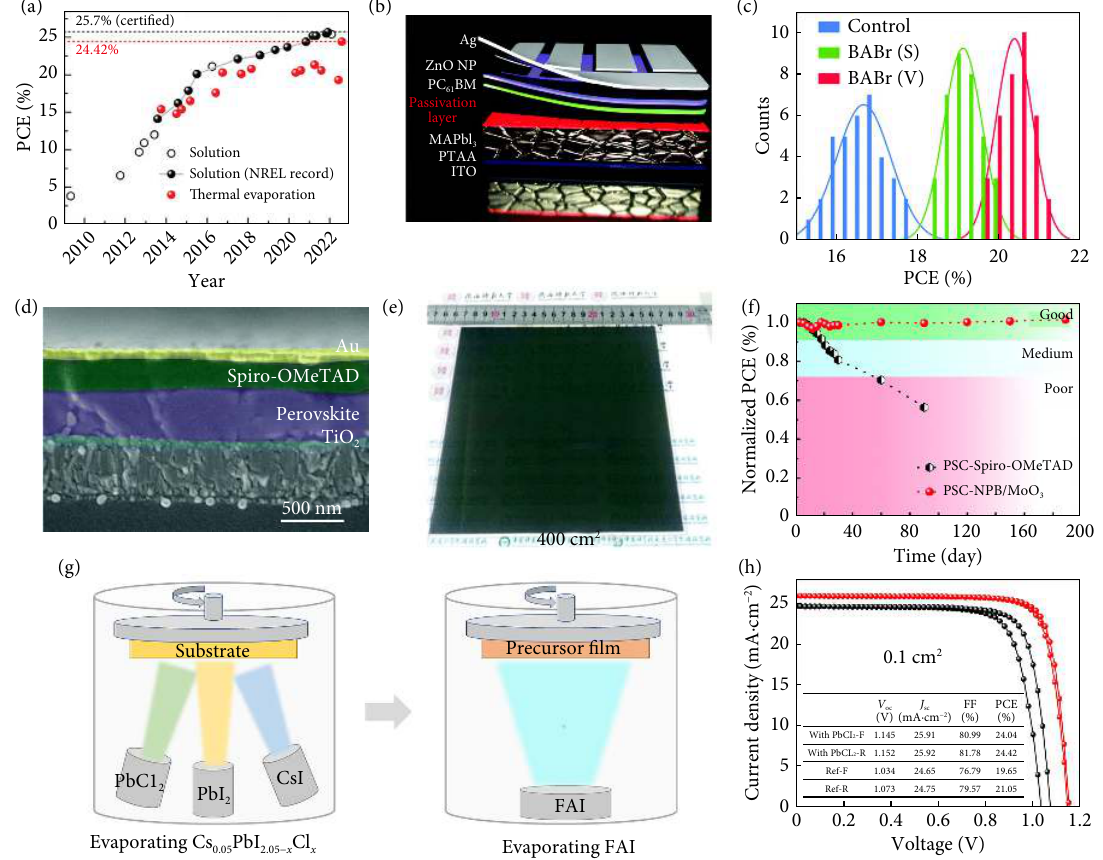
Fig. 2 Sequential evaporation protocol for perovskite films. (a) Advancements of efficiency in thermally evaporated PSCs (reprinted with permission from ref. [121], © 2022 Wiley‐VCH). ( b and c ) Device structure of sequentially evaporated MAPbI 3 PSCs (b) and PCE distributions via different post-treatment (c) (reprinted with permission from ref. [33], © 2022 The Royal Society of Chemistry). (D) Cross-sectional SEM images of sequentially evaporated Cs x FA 1− x PbI 3 films. (e) Photograph of evaporated 400 cm 2 FAPbI 3 film on glass substrate. (f) Environmental stability of unencapsulated PSCs with NPB or spiro-OMeTAD as HTL. The devices were exposed to the atmospheric environment of 35% humidity in the dark. ( d – f) Reprinted with permission from ref. [32], © 2021 The Royal Society of Chemistry. (g) Schematic illustration of the Cl-alloy mediated sequential evaporation method. (h) J – V curve and corresponding parameters of Cl-alloy mediated PSC and reference PSC. ( g and h ) Reprinted with permission from ref. [4], © 2022 The Authors, some rights reserved; exclusive licensee American Association for the Advancement of